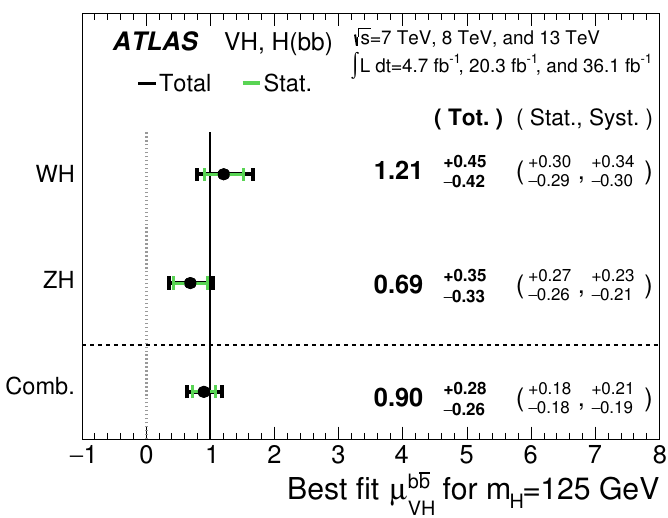
Figure 11 . The (cid:12)tted values of the Higgs boson signal strength parameter (cid:22) for m H = 125 GeV for the WH and ZH processes and their combination with the 7 TeV, 8 TeV and 13 TeV datasets combined. The individual (cid:22) values for the ( W=Z ) H processes are obtained from a simultaneous (cid:12)t with the signal strength parameters for each of the WH and ZH processes (cid:13)oating independently. The compatibility of the individual signal strengths is 34%.